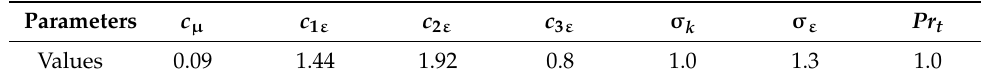
Table 1. Constants of the turbulence model.